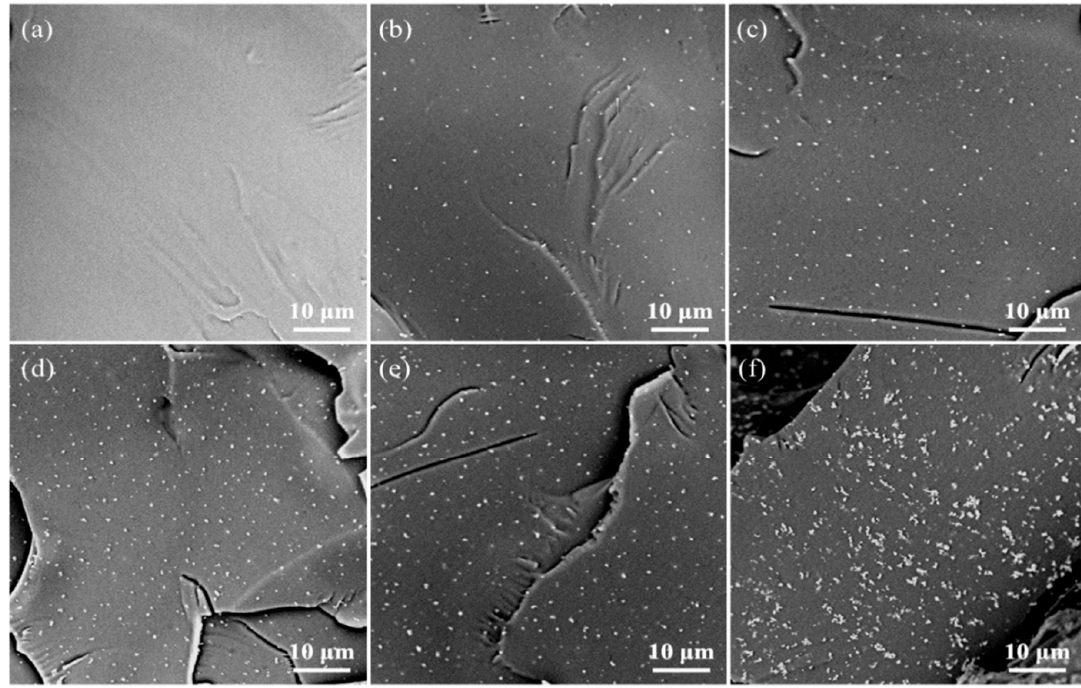
Figure 5. SEM images of fracture surfaces of scaffolds with different proportions. ( a ) PLLA scaffold, ( b ) PLLA/1%Fe 3 O 4 scaffold, ( c ) PLLA/3%Fe 3 O 4 scaffold, ( d ) PLLA/5%Fe 3 O 4 scaffold, ( e ) PLLA/7%Fe 3 O 4 scaffold, ( f ) PLLA/9%Fe 3 O 4 scaffold.